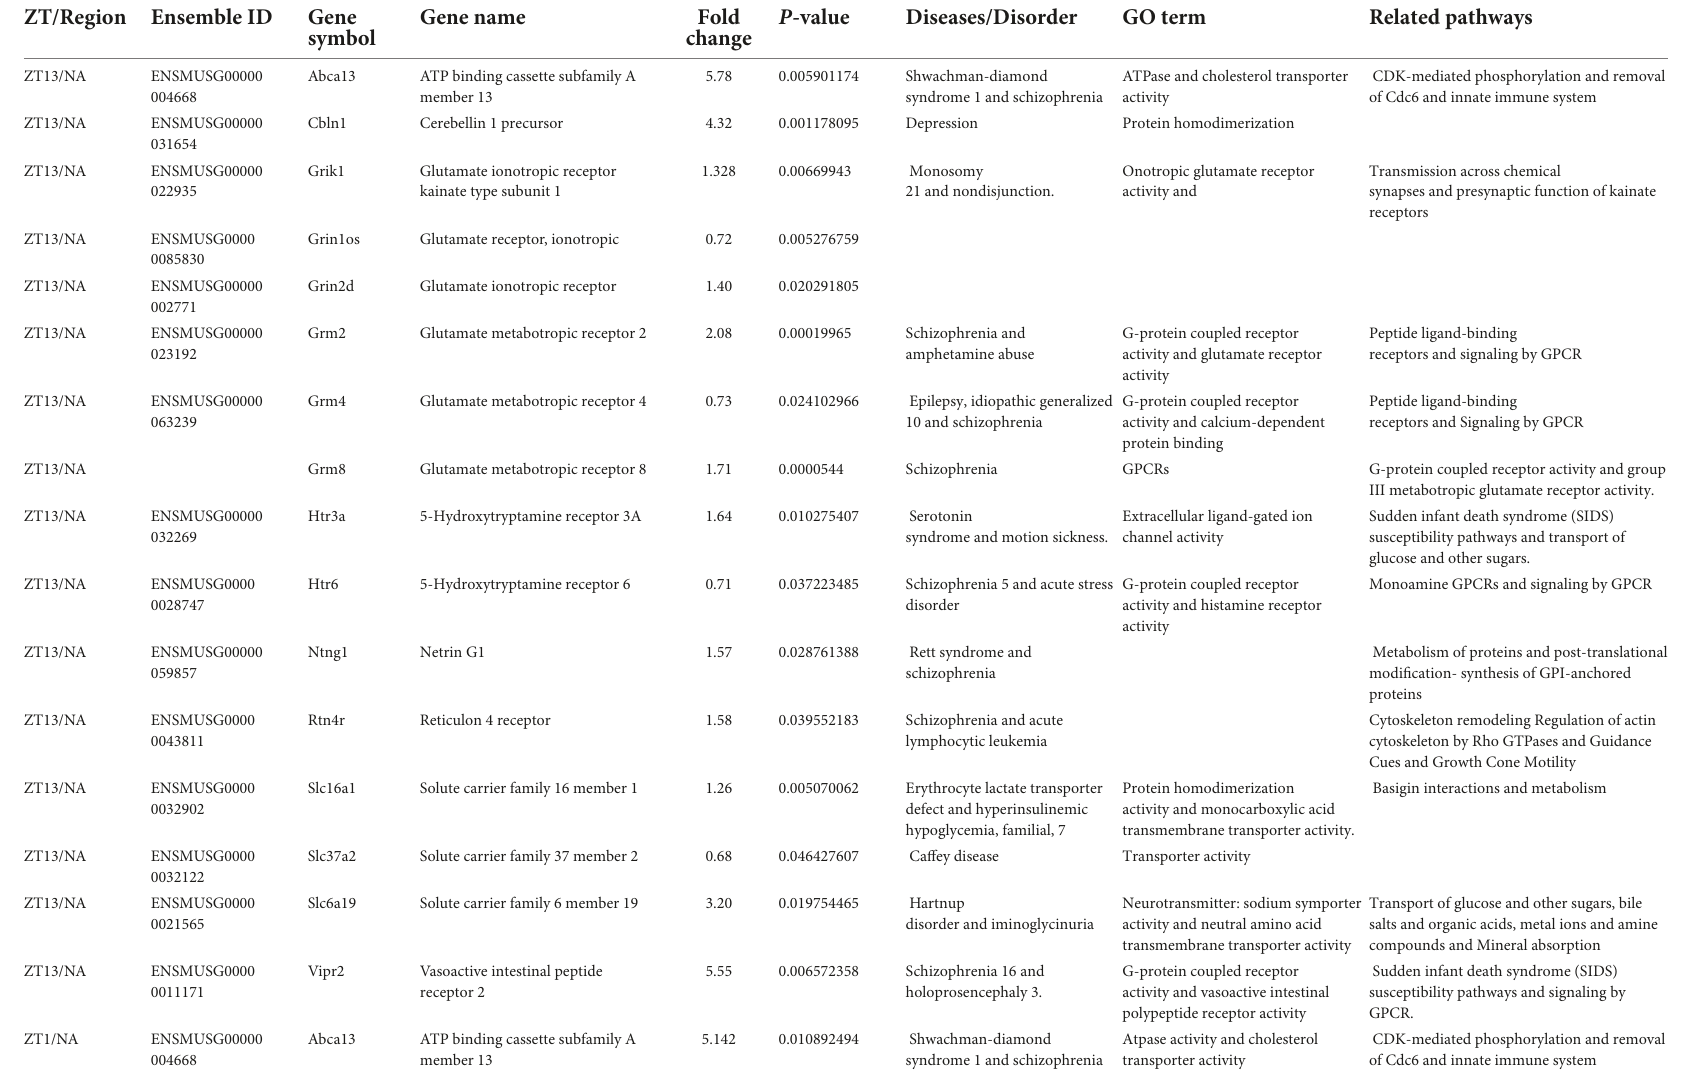
TABLE 1 Psychiatric disorders associated genes were differentially expressed under